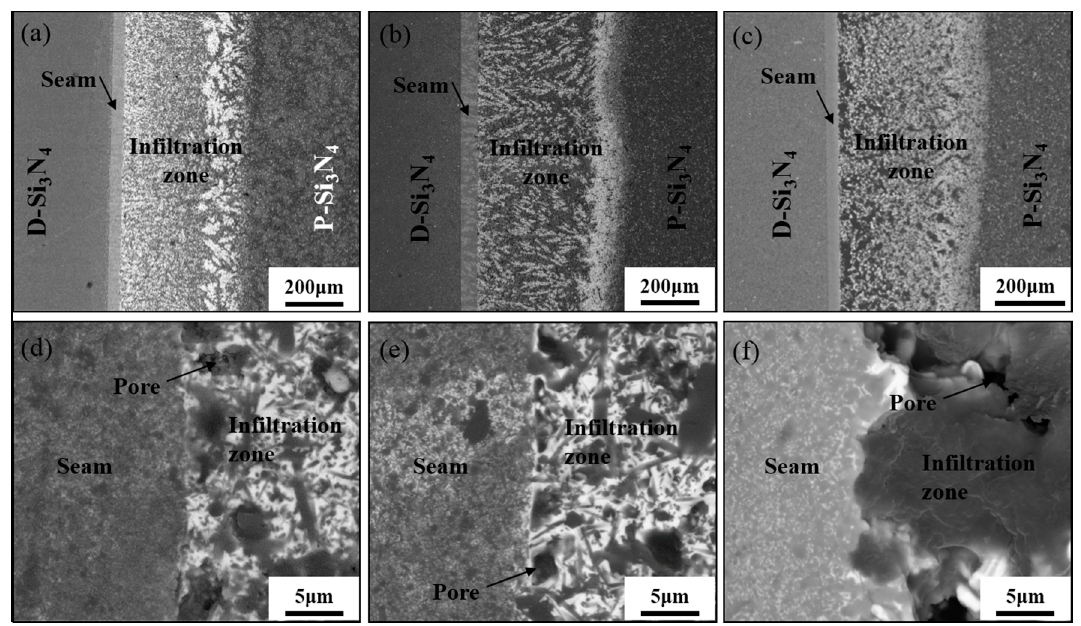
Figure 7. The microstructure of the joints bonding at ( a , d ) 1550 °C, ( b , e ) 1600 °C, and ( c , f ) 1650 °C for 30 min using Yb-SiAlON glass solder.